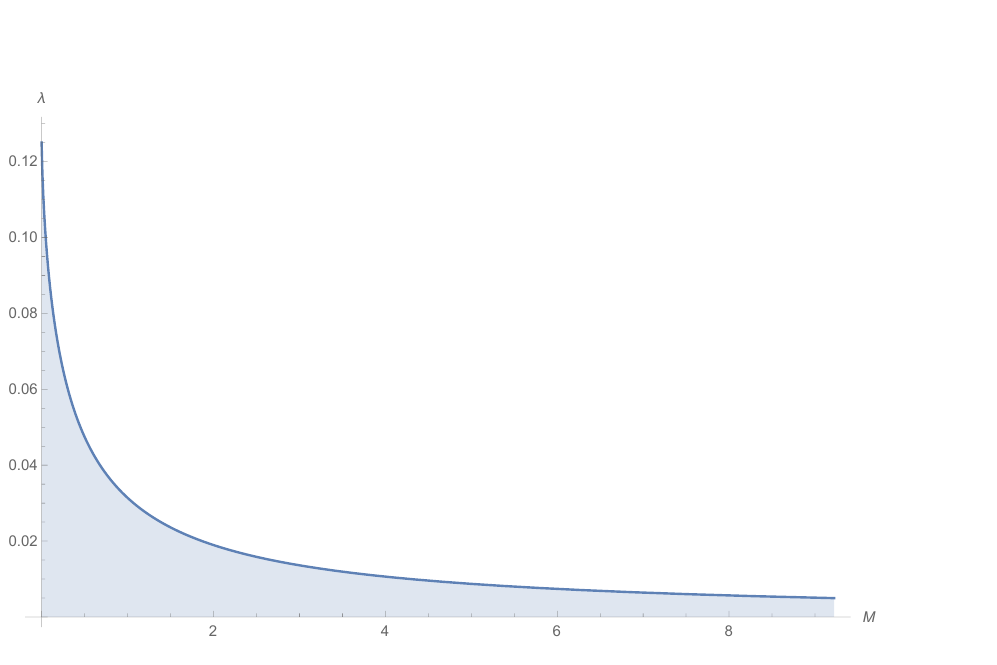
Figure 4 . The critical curve λ c ( M ) . The shaded area below the curve shows the allowed physical region on the ( M, λ ) plane where the density is real and